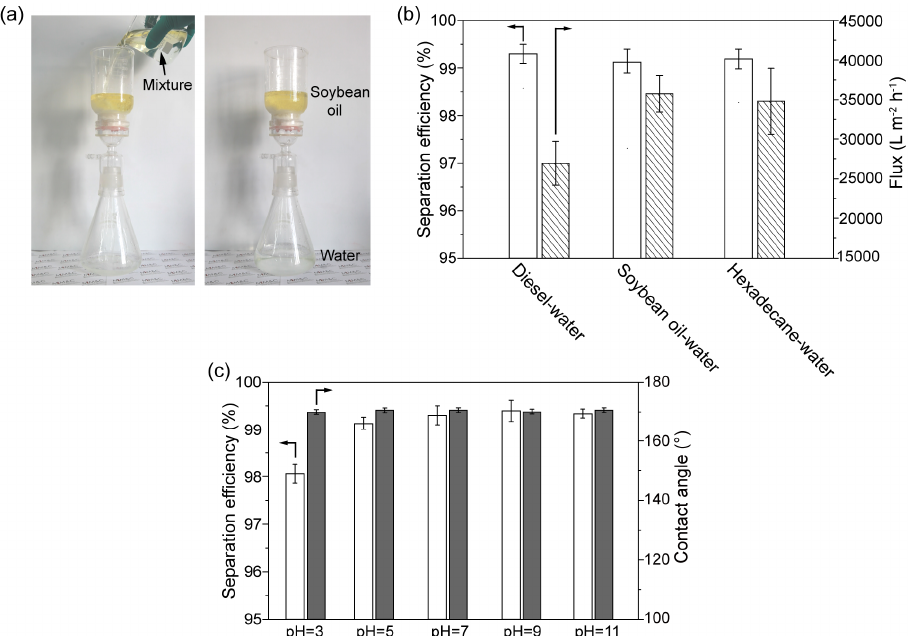
Figure 6. ( a ) Separation of immiscible soybean oil-water mixtures. ( b ) The separation efficiency and the flux during the separation of immiscible diesel-water, soybean oil-water and hexadecane-water mixtures, the average separation efficiencies were higher than 99% for the separation of various immiscible oil-water mixtures and the separation flux was up to 42,000 L m − 2 h − 1 . ( c ) The separation efficiency and underwater oil contact angle in aqueous environments with pH values of pH = 3 to pH = 11. There were no obvious variation on underwater oil contact angles during variation of pH values, the oil-water separation efficiency was stable above 99% in the range of pH = 5 to pH = 11, whereas the separation efficiency decreased to 98% when pH = 3.